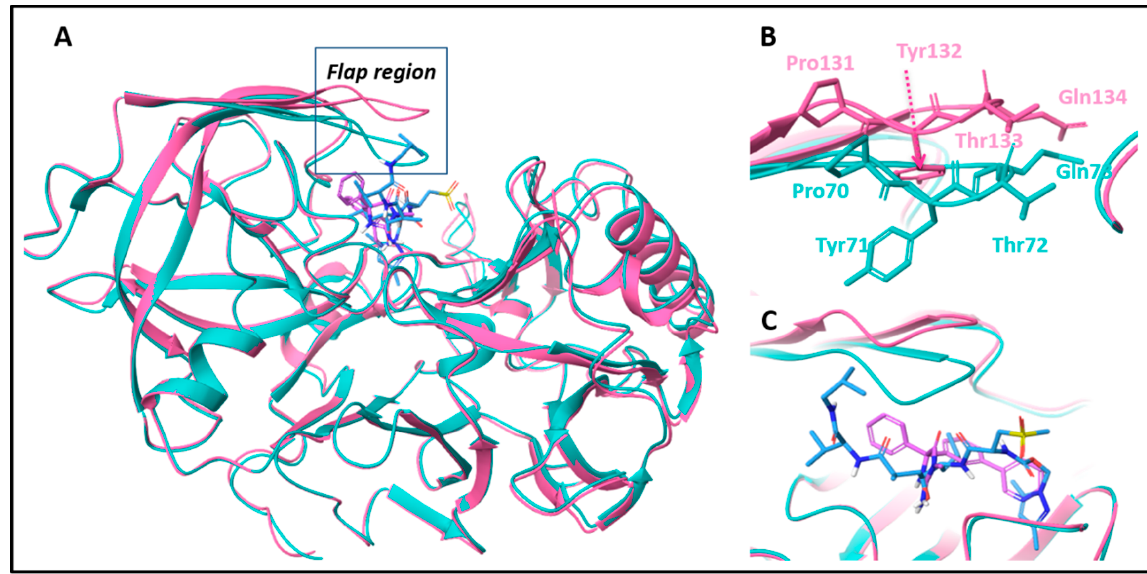
Figure 3. BACE-1 superimposed structures 2G94 (cyan) and 4DJW (pink) in closed and open conformations, respectively. ( A ) the whole enzyme. ( B ) An enlargement of the flap region with its residues that have the largest RMSD values (these are the same residues, but with different numbering in PDB structures 70–73 or 131–134). ( C ) ligands in the binding site: 2G94 peptidomimetic ligand in light blue, 4DJW aminohydantoin ligand in pink. The illustration was made with Maestro 11.0, Schrödinger.